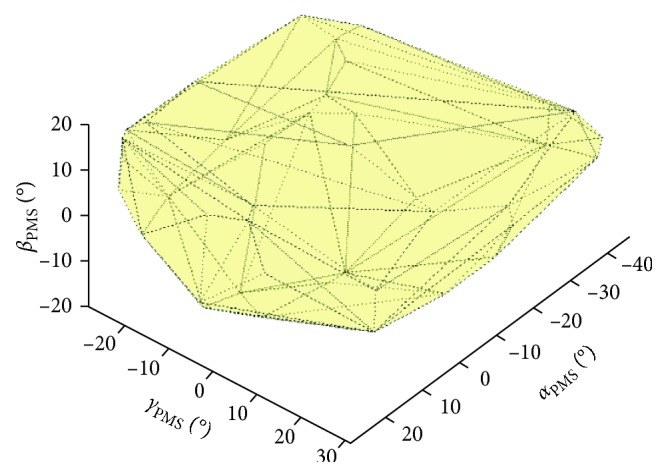
PMS of ankle joint.